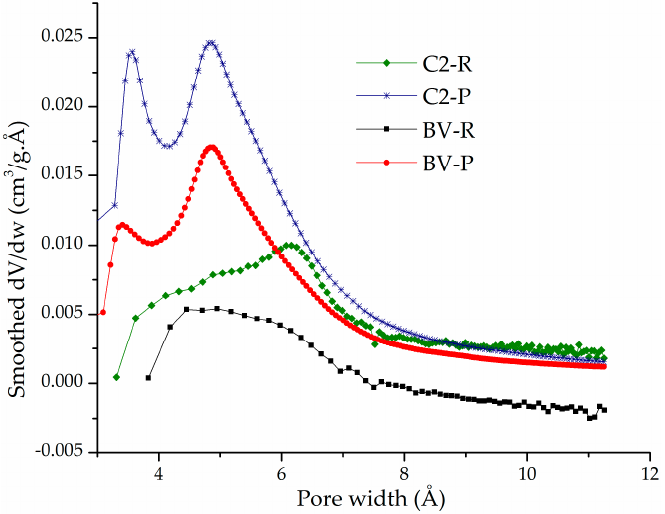
Figure 5. Horvath and Kawazoe micropore width distributions of refined (R) and pillared (P) forms of aluminosilicates C2 and BV.